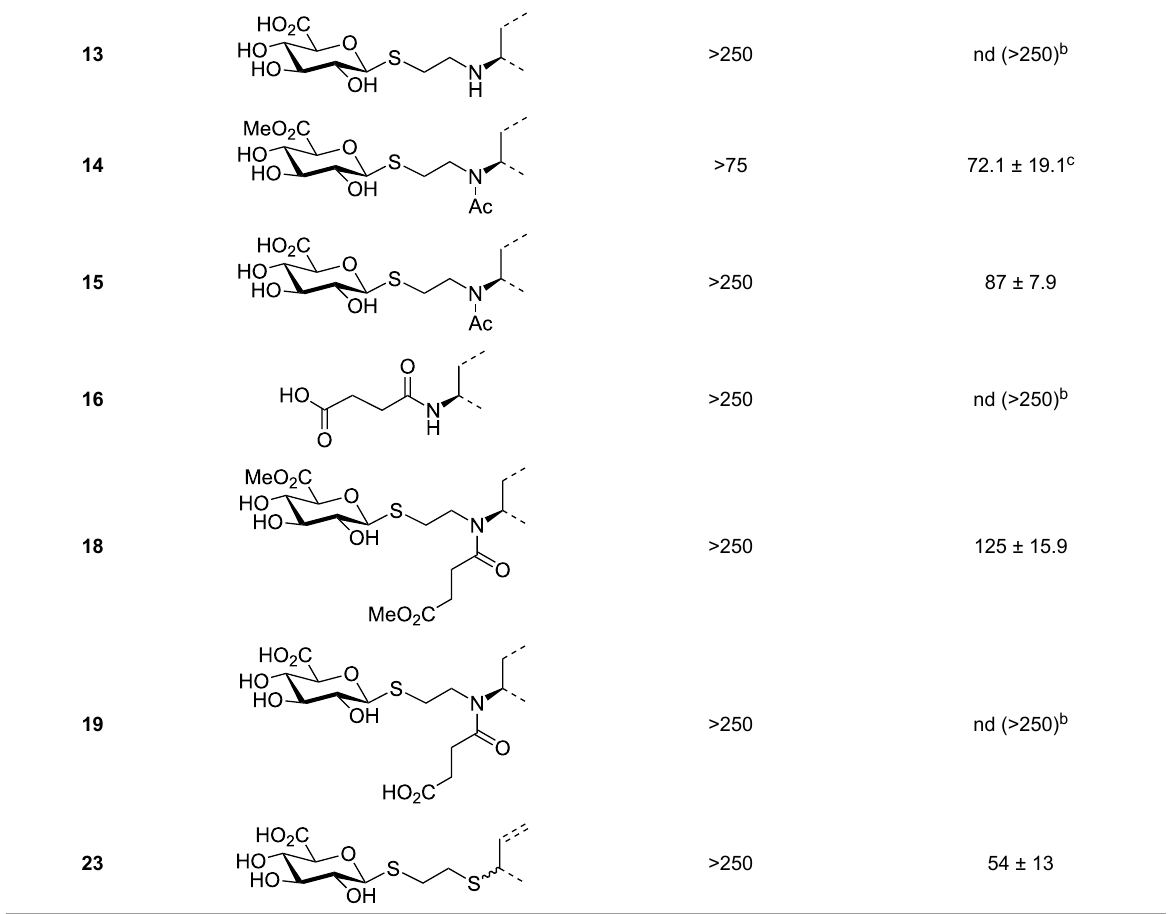
Table 1: Cytotoxic concentration 50% (CC 50 ) of compound-treated uninfected cells and antiviral activities, shown as half-maximal inhibitory concen- tration (IC 50 ) values of glycyrrhizin ( GL ) analogues.